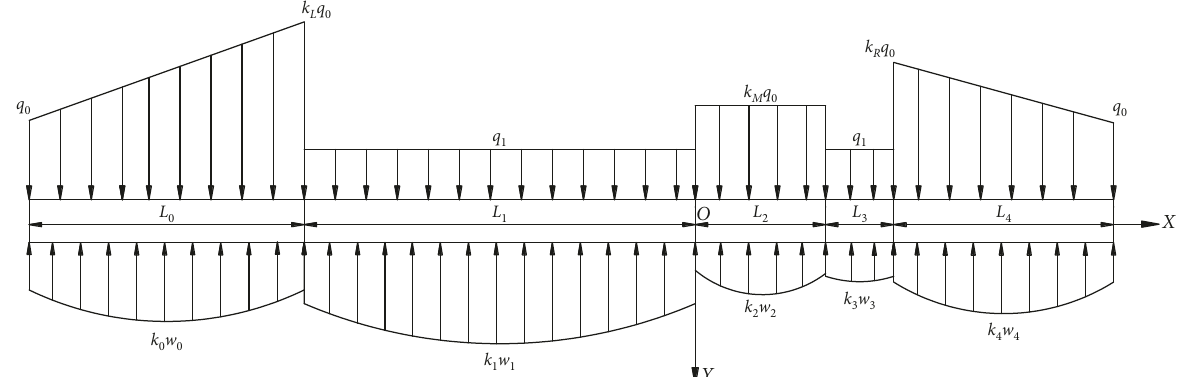
Figure 3: Mechanical model of mining first